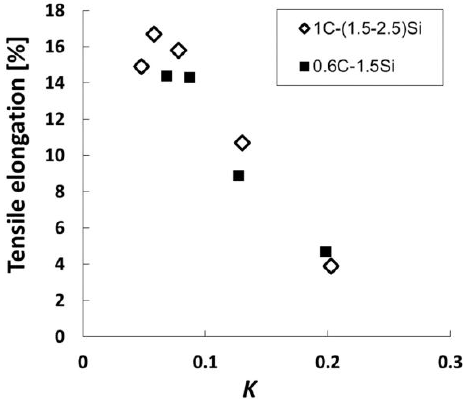
Figure 10. Tensile elongation vs. K , the fitting parameter of Equation (3), for different nanobainitic structures, from steel containing 0.6 and 1 C wt %. Adapted from references [53,66]. Metals 2016 , 6 , 302